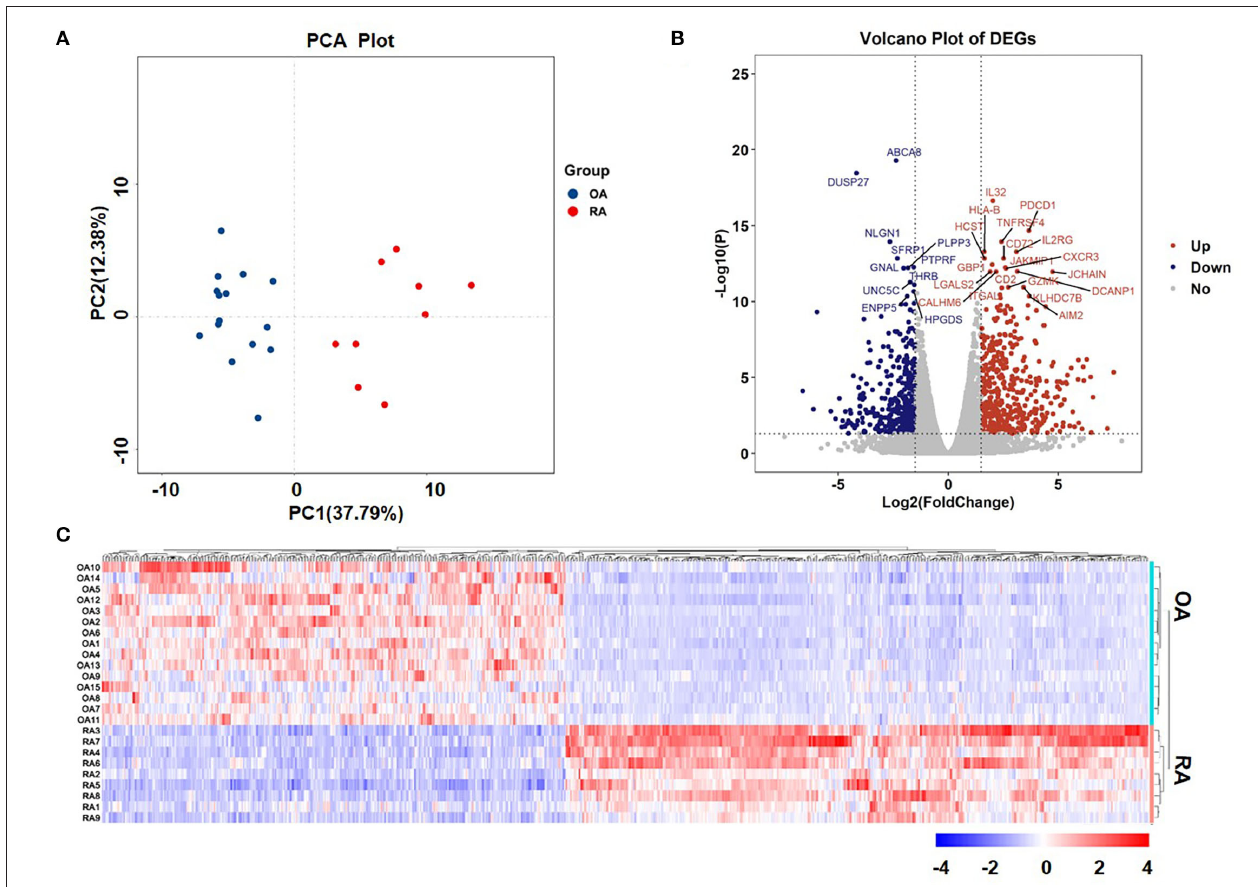
FIGURE 1 | Principal component analysis (PCA) plot of samples and volcano plot and heat map of the differentially expressed genes (DEGs). (A) PCA plot of samples and (B) Volcano plot of DEGs. The red dots represent upregulated genes and the blue dots represent downregulated genes. The tagged genes are the top 30 genes with a false discovery rate (FDR) < 0.05. (C) Heat map of